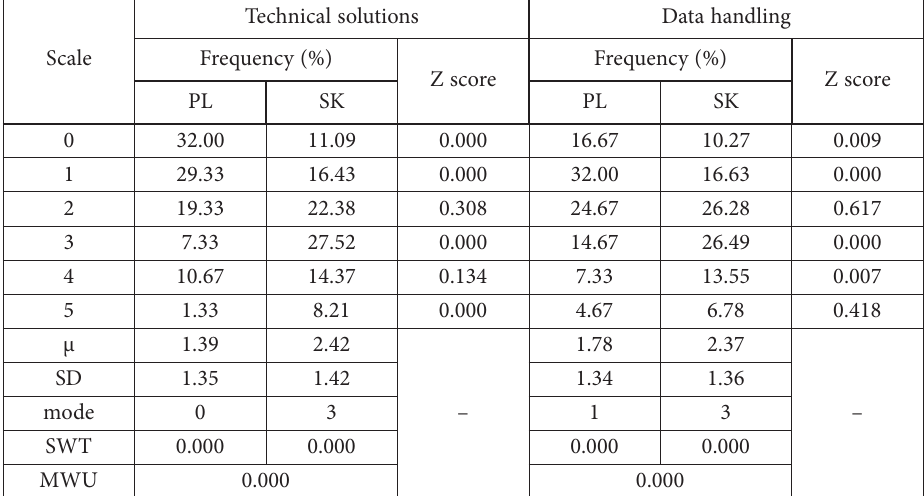
Table 4. Technical solutions and data handling of SMEs